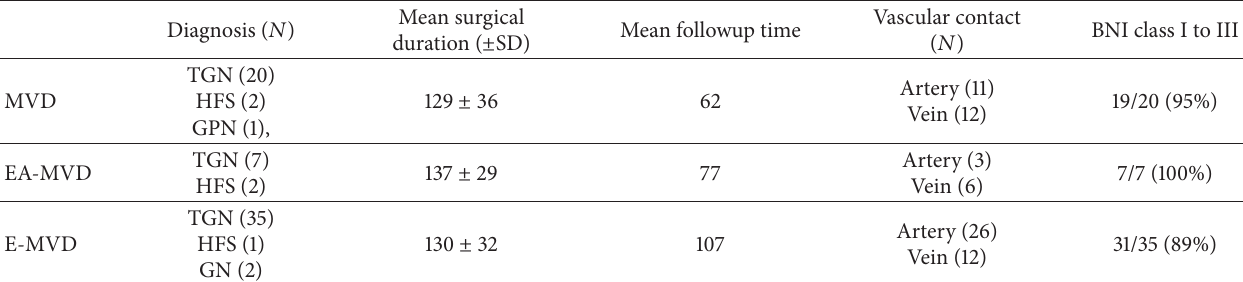
Table 1: Patient summary.